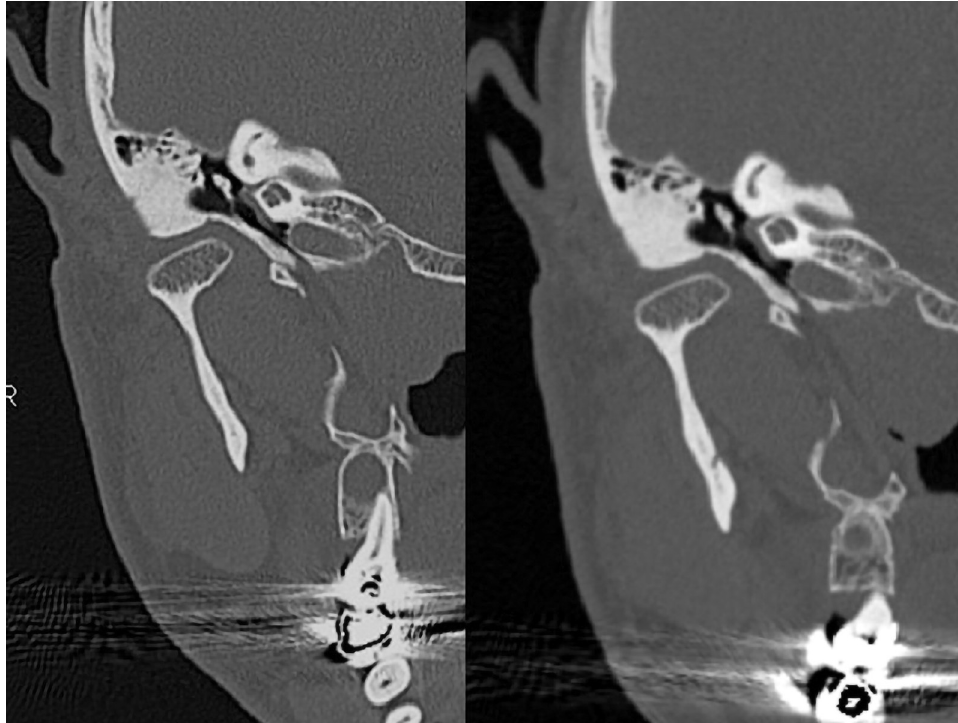
Fig 3. Eustachian tube only minimally visible before and after Valsalva maneuver.